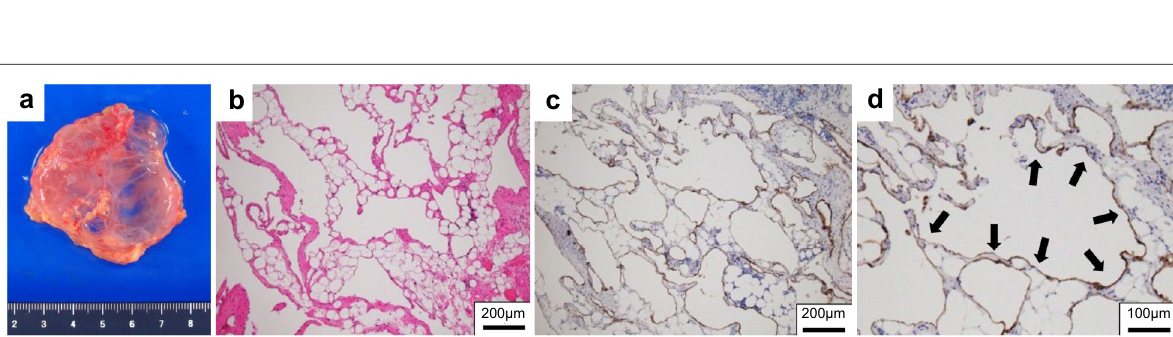
Fig. 4 Pathological findings. Resected specimen of the axilla cystic tumor ( a ). In the cystic region, the inner surface was lined with flattened endothelial cells ( b ; hematoxylin–eosin staining). The endothelial cells were positive for D2-40 by immunostaining and determined to be lymphatic vessels ( c and d